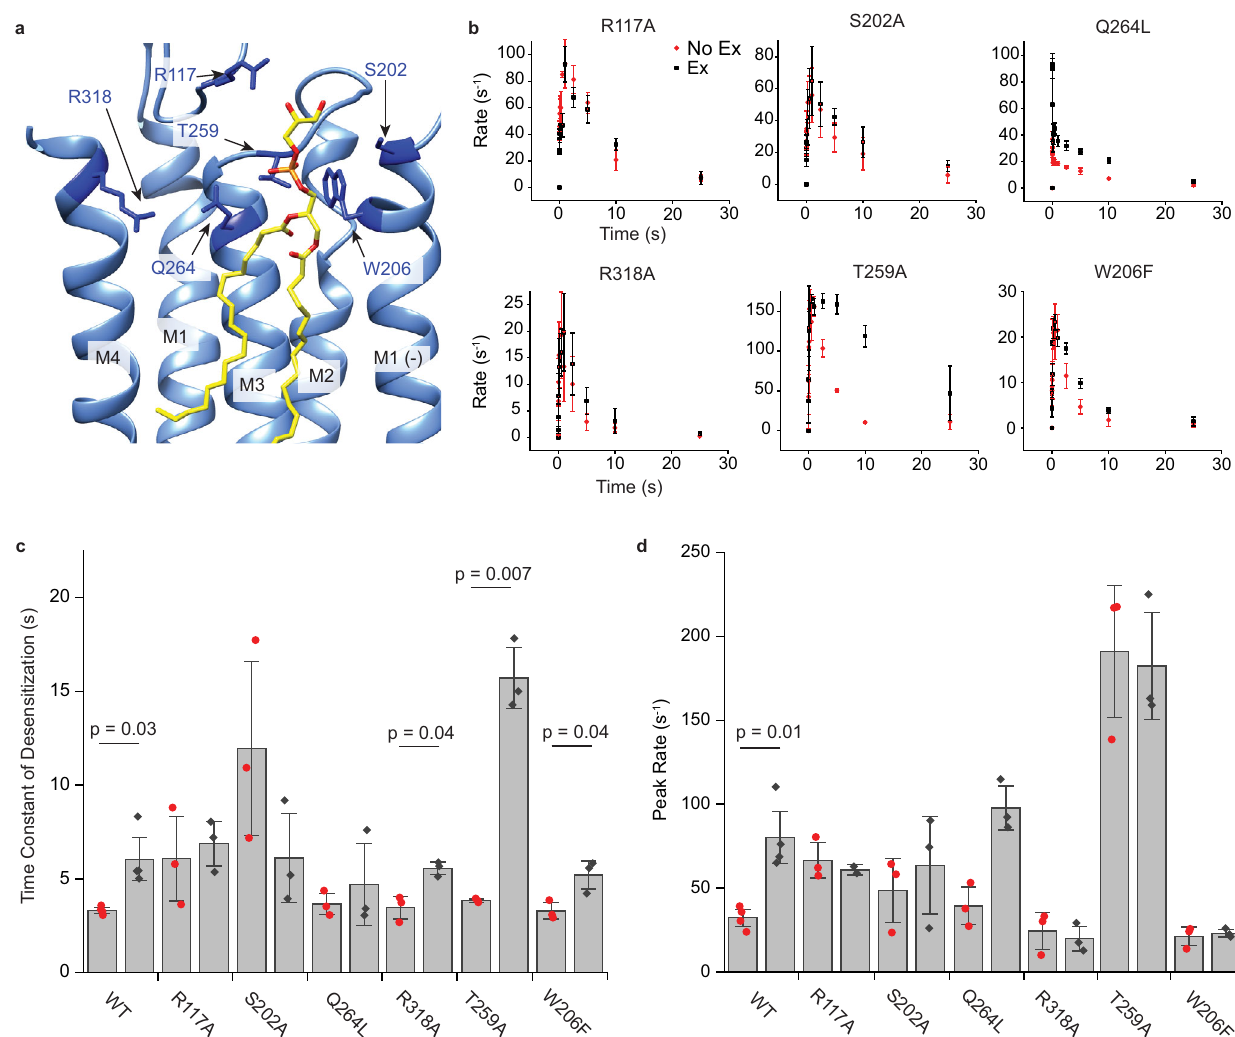
Fig. 6 | Mutational analysis of the outer lea fl et phospholipid binding site. a ELIC5 CA structure showing POPG (yellow) at the outer lea fl et site and residues (dark blue) targeted by mutagenesis. b Tl + fl ux rates of mutants in response to 10mM propylamine for no-exchange (red) and exchange (black, 25mol% POPG in the outer lea fl et) conditions ( n =3). Source data are provided as a source data fi le. c Weightedtimeconstantofdesensitizationinresponseto10mMpropylaminefor